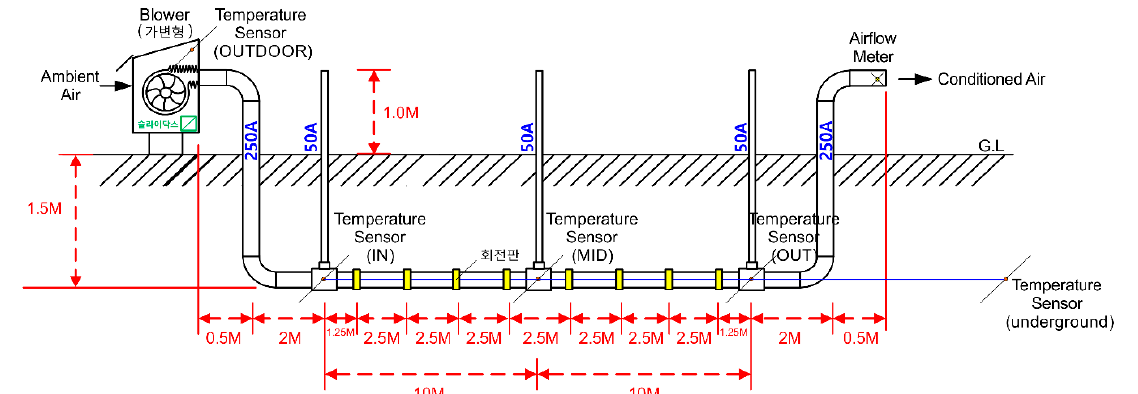
Figure 1. Baseline case.